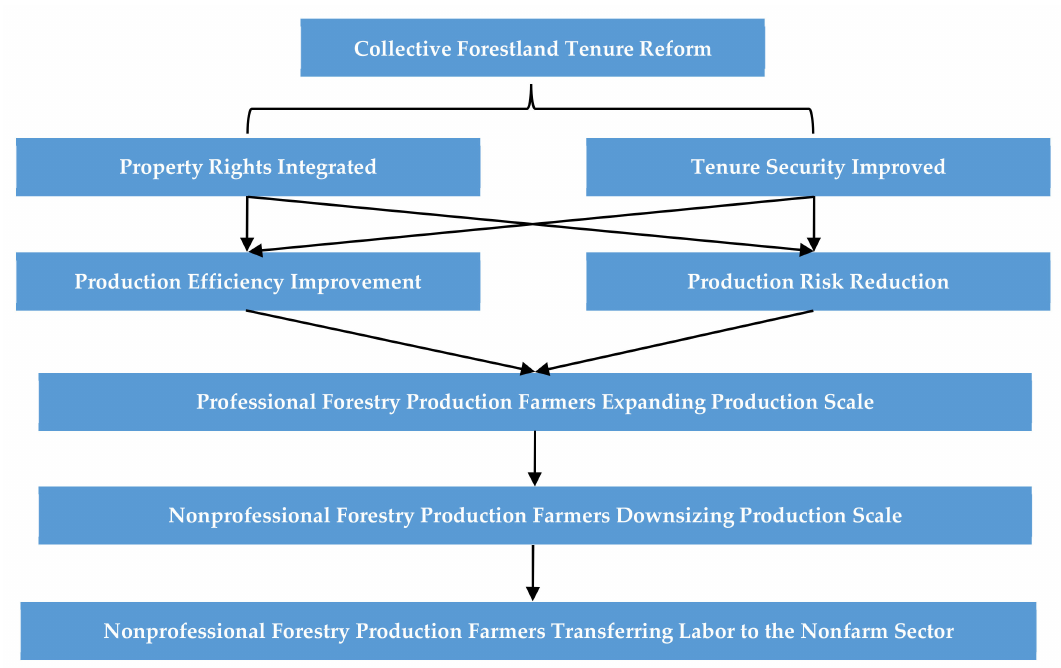
Figure 1. Conceptual framework: The mechanisms through which the Collective Forestland Tenure Reform a ff ects rural labor